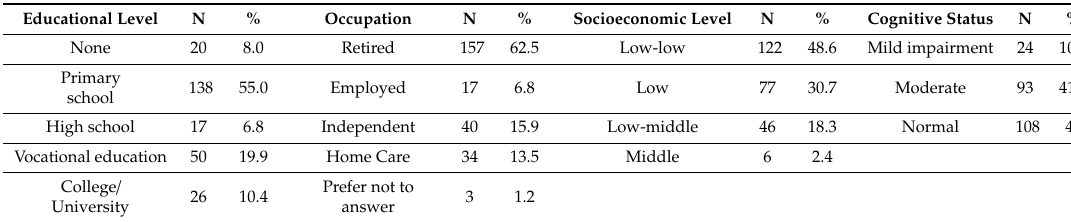
Table 1. Characteristics of the